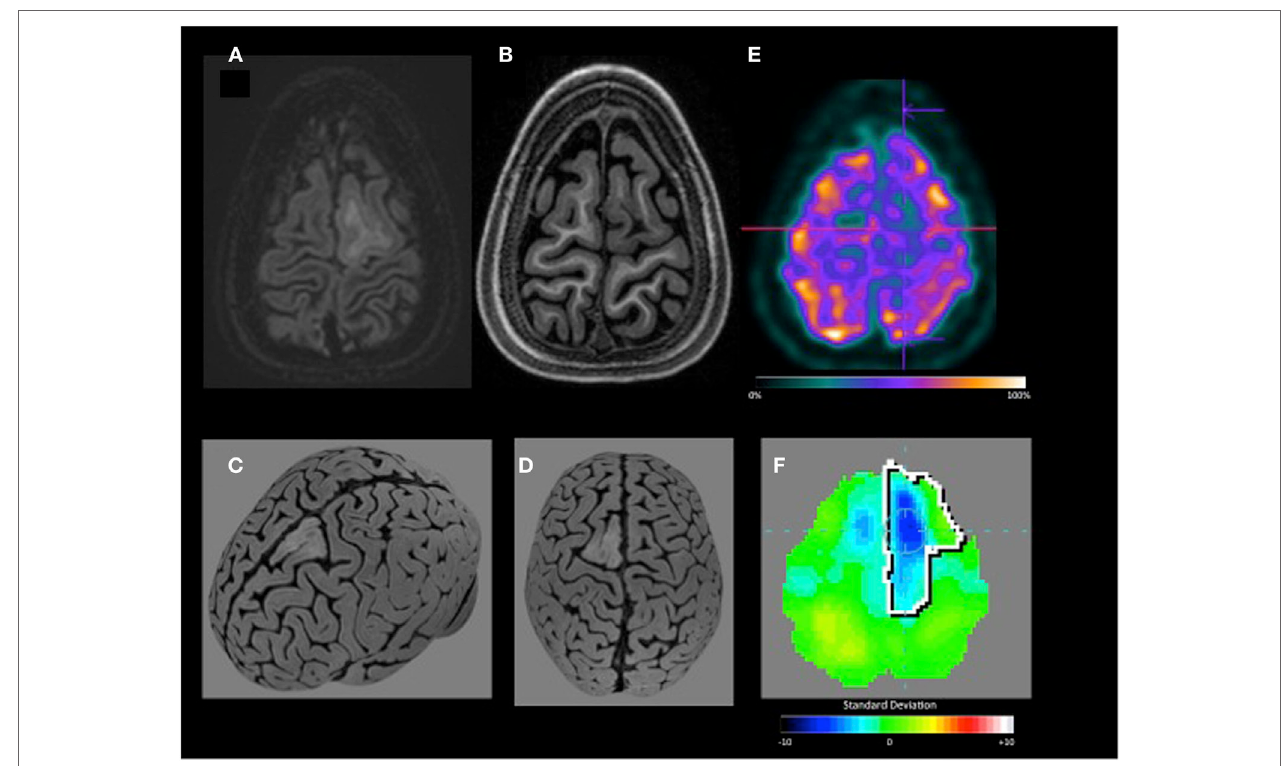
FigUre 1 | Left frontal lobe angiocentric glioma. This patient with histologically confirmed angiocentric glioma was included because focal cortical dysplasia was one of the differential diagnoses. (a,B) Double inversion recovery and T1 axial MRI show lesion in the left superior frontal gyrus, better characterized of (c,D) curvilinear reconstruction. (e) Axial visual-positron emission tomography (PET) shows hypometabolism in the left frontal. (F) Quantitative-PET confirms hypometabolism in the left frontal lobe with − 4.3